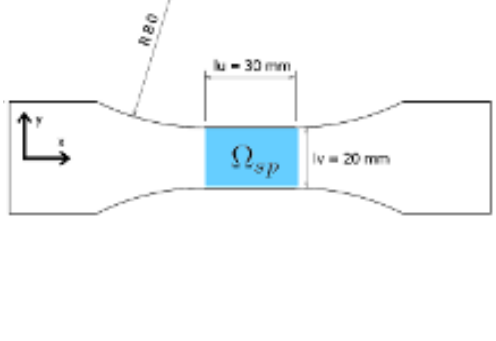
Fig. 1. Specimen geometry. maximal stress made plastic strain appear, the cyclic loading was applied during a high enough number of cycle so that the material reached a steady state (the mean strain remains constant). As the loading ratio is greater than zero, no cyclic plastic strain occurred in this steady behaviour. Thus, the dissipative energy measured in these conditions is only due to internal friction.